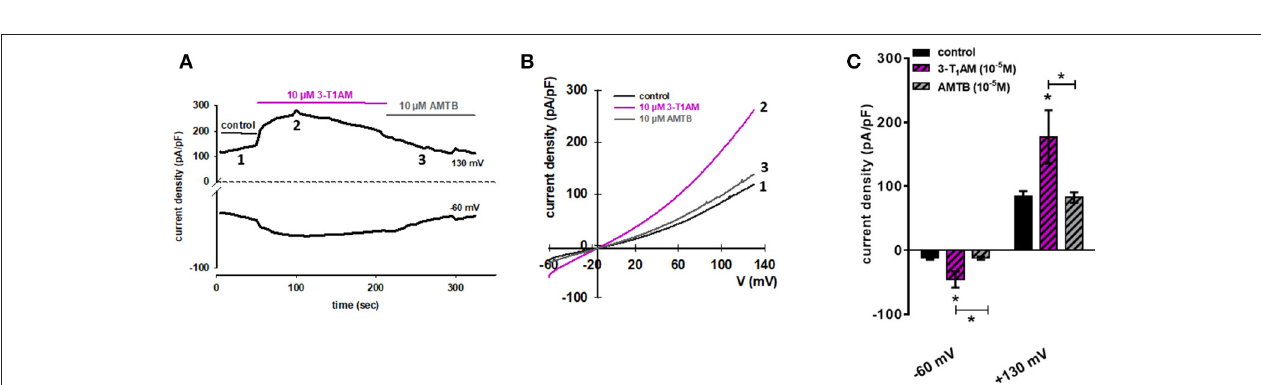
FIGURE 7 | 3-T1AM activates whole-cell currents in N41 cell line. (A) Time course of whole-cell currents at − 60mV (lower trace) and 130mV (upper trace) showing the current activation by 10 µ M 3-T 1 AM (left). (B) Original traces of 3-T 1 AM activated current responses to voltage ramps from − 60mV up to + 130mV (right). Currents are shown before application (labeled as 1) and during application of 1 µ M 3-T 1 AM (labeled as 2) and in the presence of 10 µ M AMTB (labeled as 3). (C) 10 µ M 3-T 1 AM increased inward and outward whole-cell channel currents in N41 cells and this effect was strongly suppressed in the presence of 10 µ M AMTB. Currents are shown before application (control), during application of 10 µ M 3-T 1 AM and in the presence of 10 µ M AMTB ( n = 10). Whole-cell currents were recorded using step and ramp protocols involving voltage steps of 10mV ranging between − 60 to + 130mV for 400ms. The currents were normalized to capacitance to obtain current density (pA/pF). Statistical significance was determined by one-way ANOVA, comparing the basal current density (pA/pF) against 3-T 1 AM and AMTB. Data are the mean ± SEM of at least 10 independent experiments; * p ≤